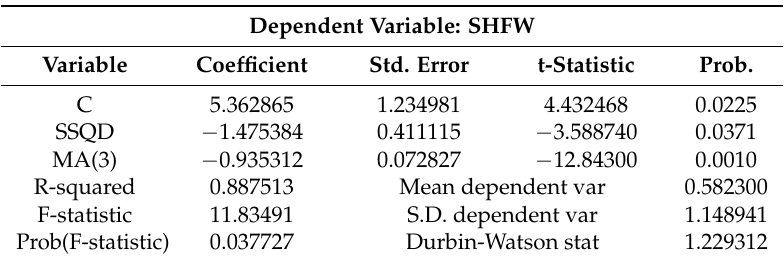
Table 13. Damage to the housing equation measurement model estimation results.